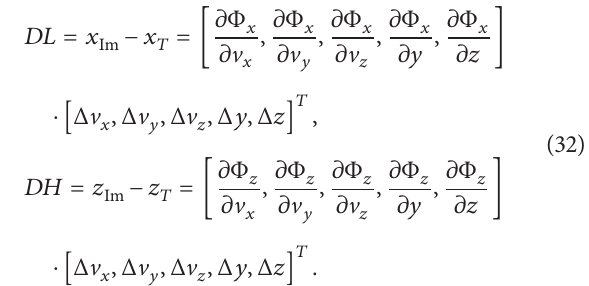
4.1. Impact Point Prediction Based on Perturbation Theory. (𝑥 , 𝑦 , 𝑧 ) and 𝑋 𝑋 0 0 0 0